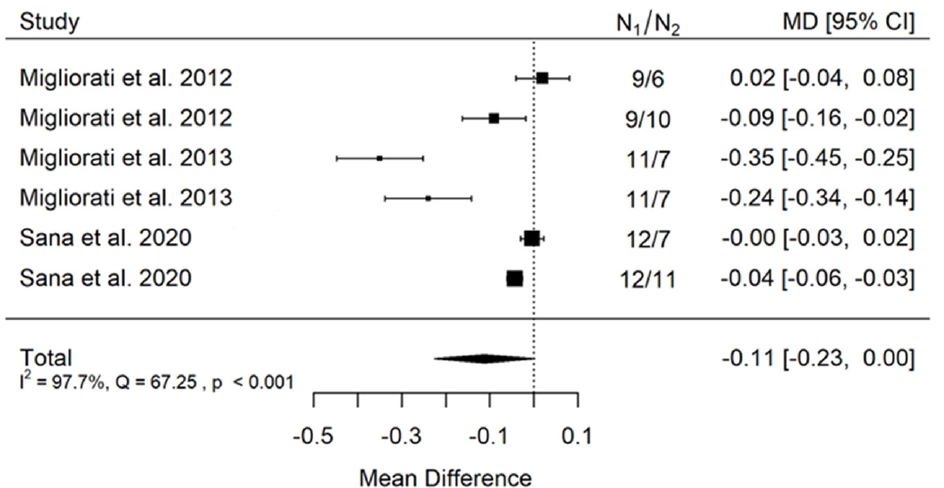
Figure 3. Funnel plot for evalutaion of thread pitch dimension infulence on pull-out strentght in artifical bone model studies. (B) animal bone model There is small significant ( p = 0.005) negative effect size. Study results are consistent— heterogeneity is insignificant ( p = 0.157), and only about 40% of the variability comes from heterogeneity (Figure 4). The funnel plot does not reveal publication bias (Figure 5).